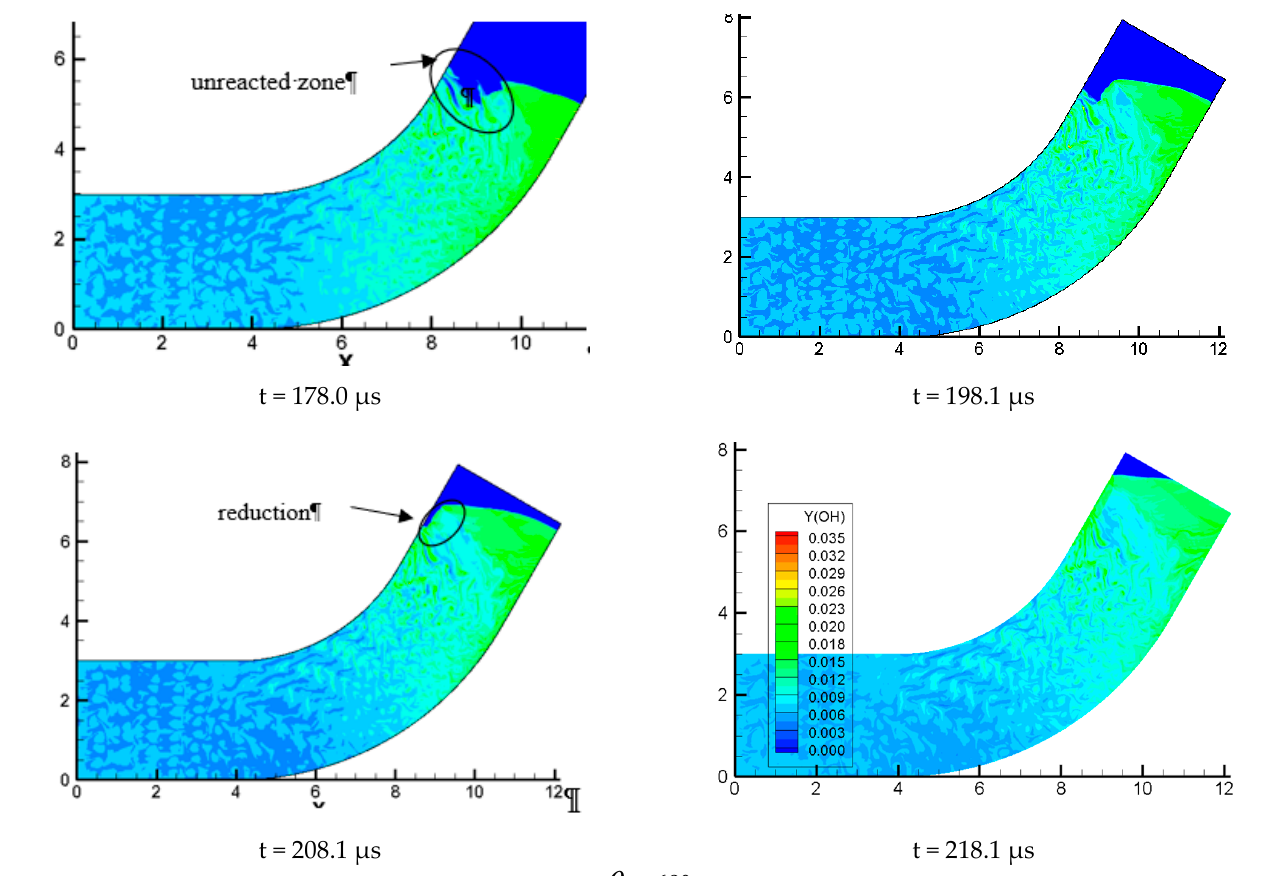
Figure 11. Profiles of OH components with different propagation characteristics.